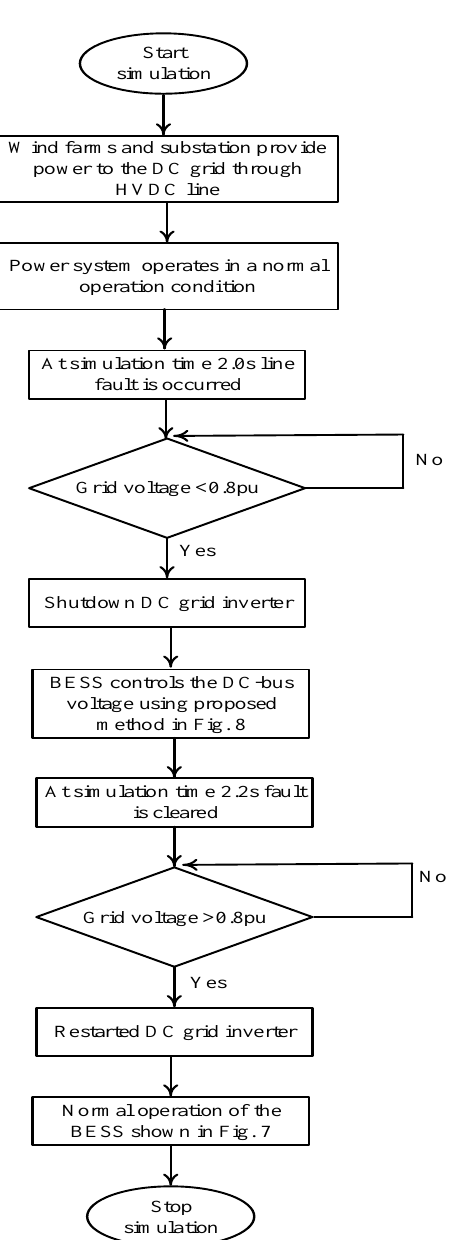
Figure 11. Flowchart of the proposed control algorithm.